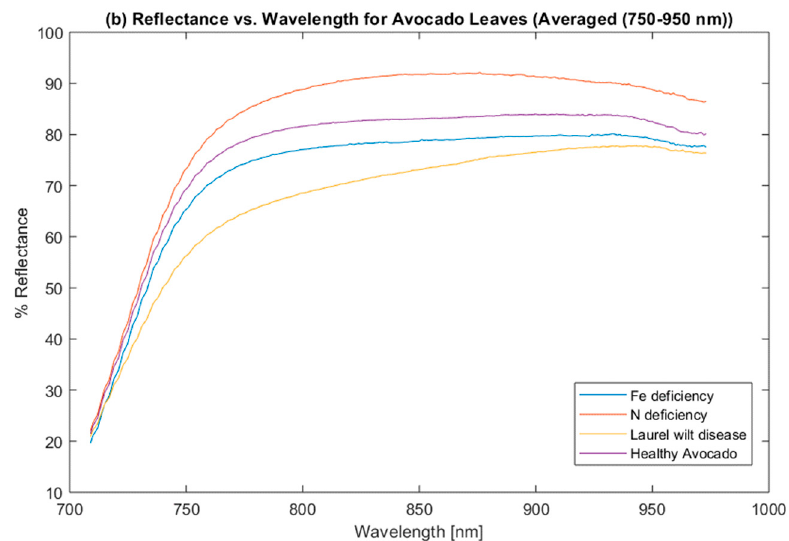
Figure 2. Reflectance signature (data) for Fe ‐ Deficient, Laurel wilt, N ‐ Deficient, and Healthy avocado: ( a ) 400–970 nm Range ( b ) 750–950 nm. Note variance in spectrum and inflection point variations distinct between leaf groups.